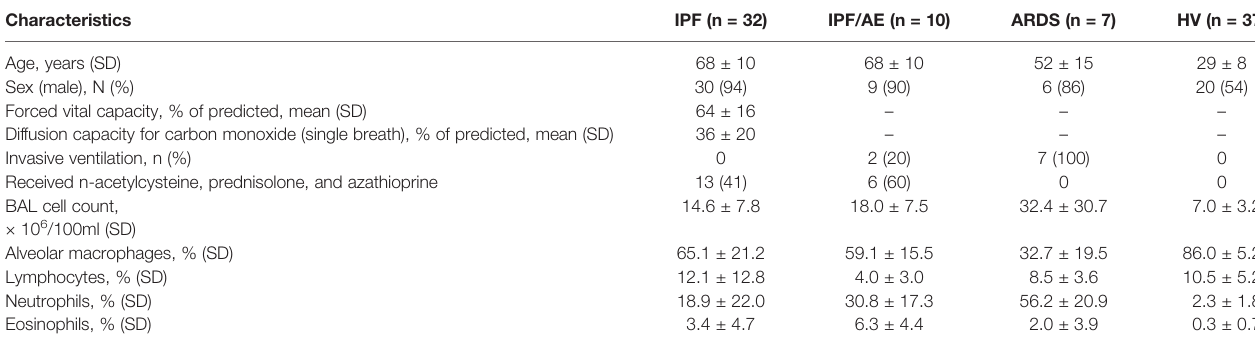
TABLE 1 | Study population and BAL differential cell